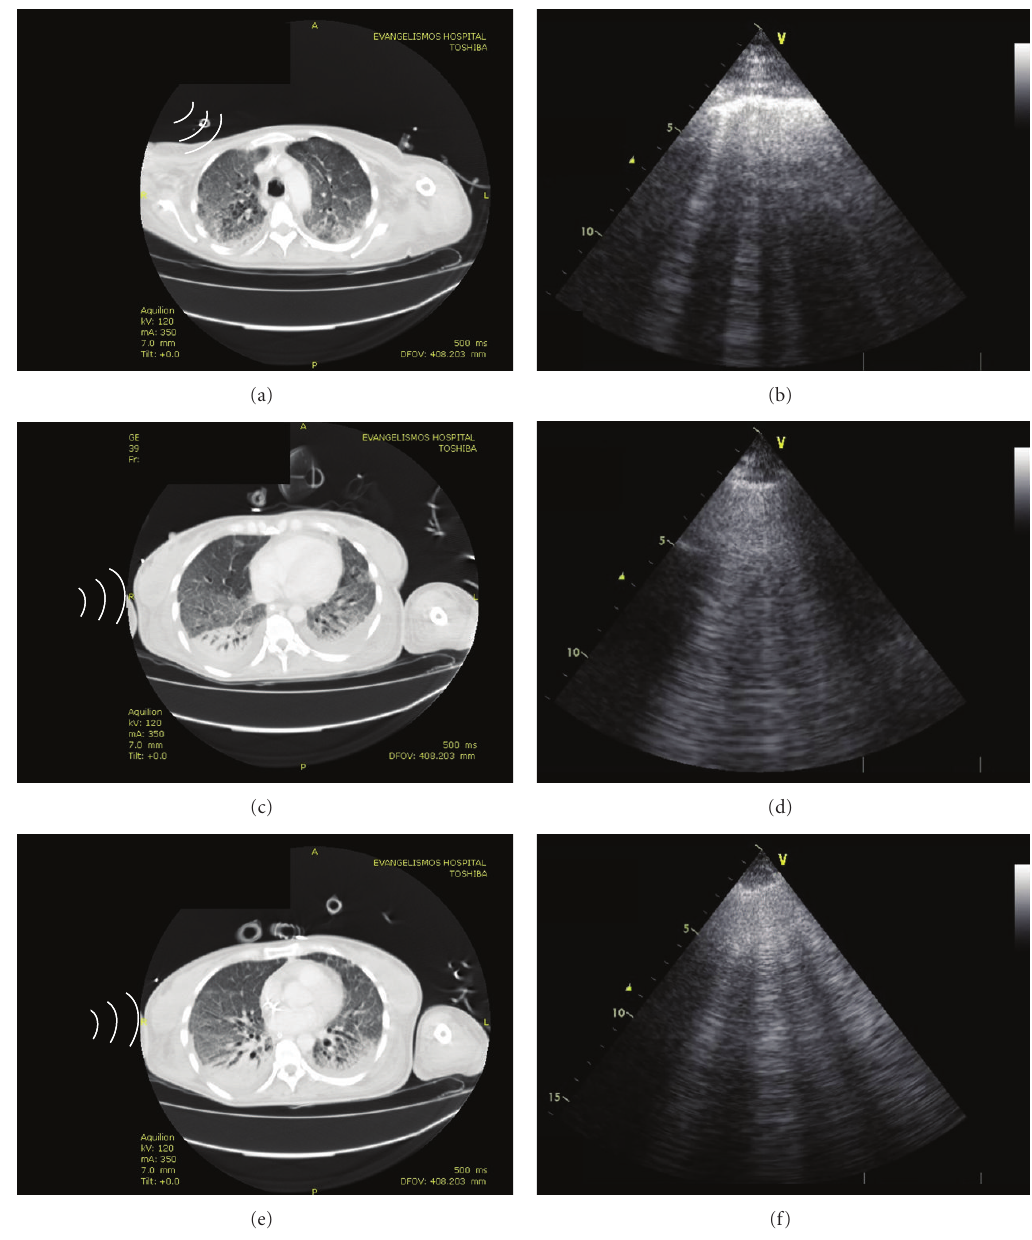
Figure 4: Computed tomography (CT) scans showing areas of “ground glass” opacification and bilateral-dependent areas of dense consolidation in a patient with acute respiratory distress syndrome (right panel). Lung ultrasound scans in the same patient depicting B-lines arising from the pleural line, confirming thus a pattern of di ff use alveolar-interstitial syndrome (left panel). Table 2: Accuracy of lung ultrasound in diagnosing alveolar-interstitial syndrome in respective pulmonary